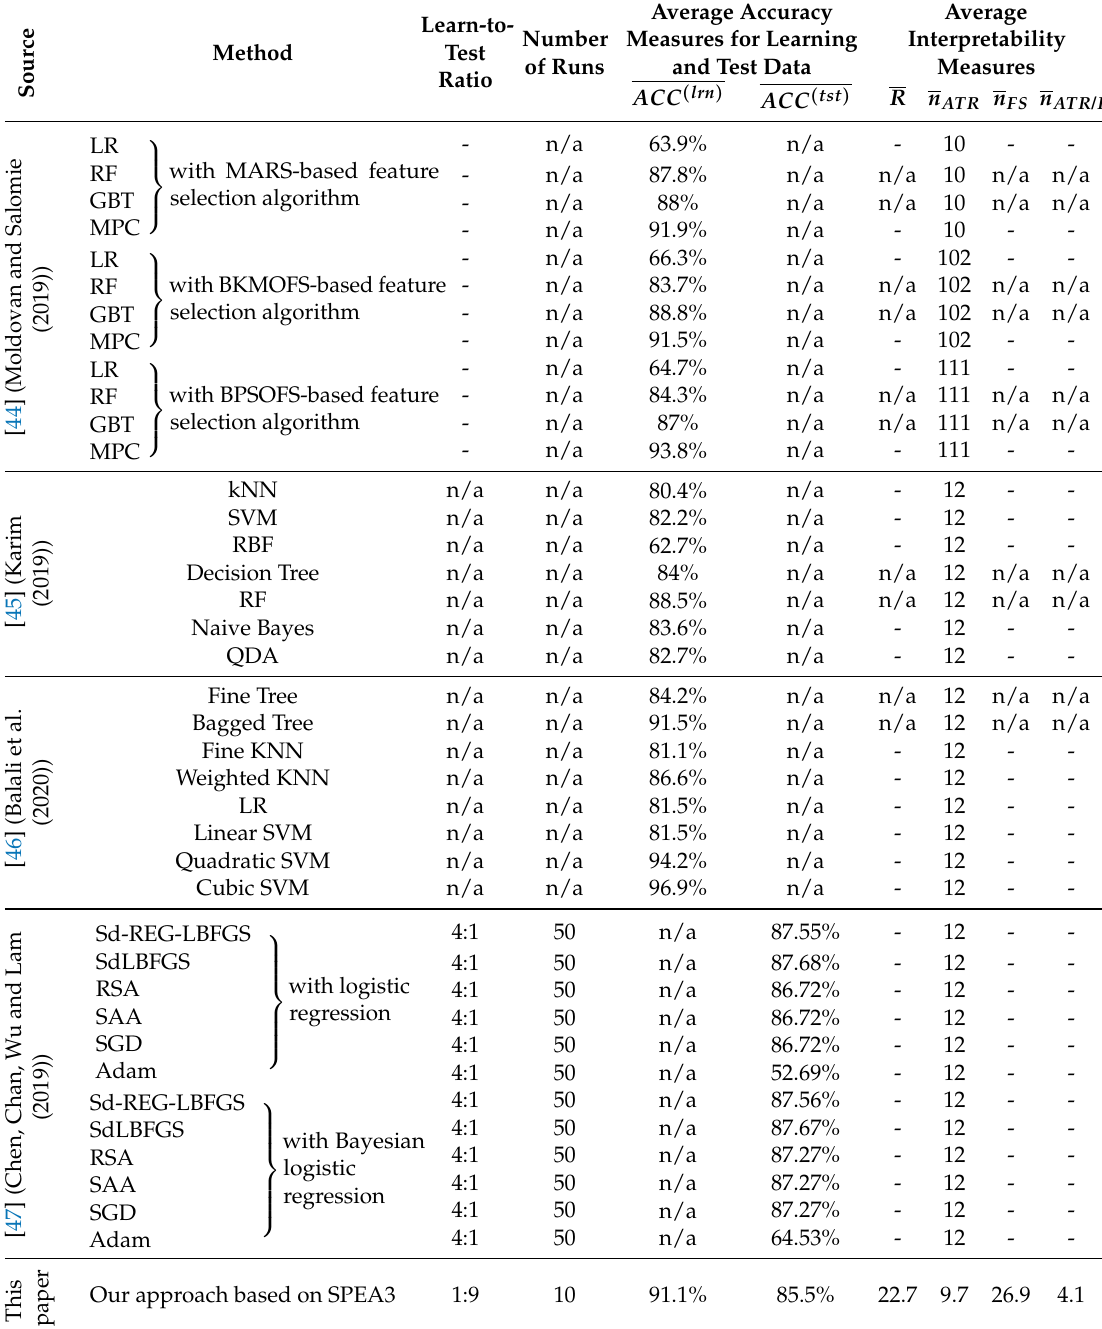
Table 7. Results of our approach and comparison with alternative methods for the Electrical Grid Stability Simulated Data Set